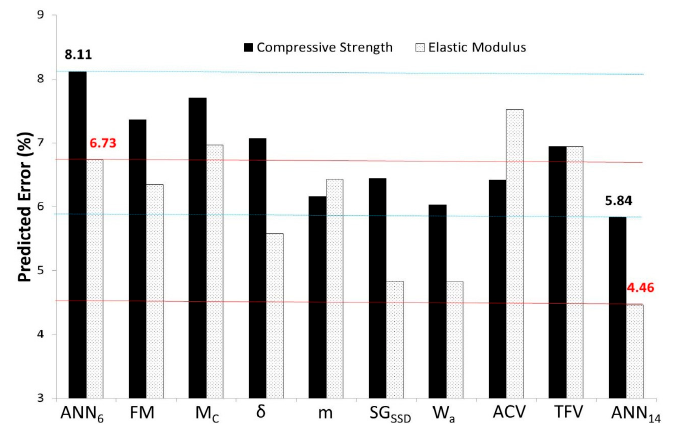
Figure 6. Influence of each uncertainty on the properties of RAC relative to models ( ANN 6 ) with only “certainties” as inputs—Stage a.